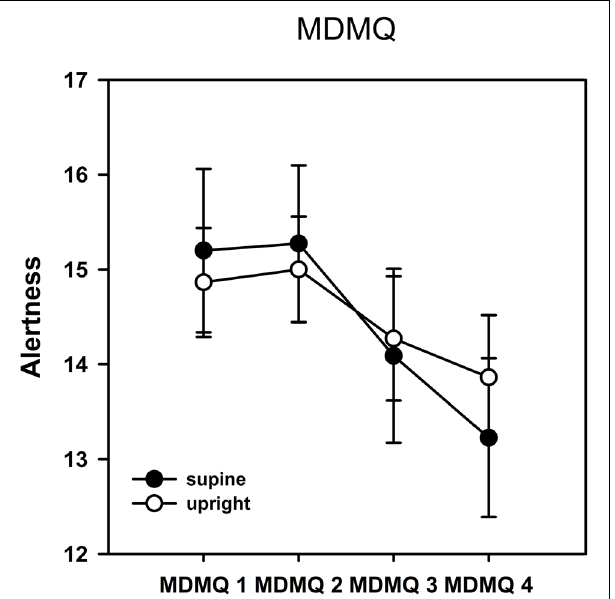
FIGURE 2 | Results from the Multidimensional Mood Questionnaire (MDMQ)–alertness scale. Error bars indicate SEM. Alertness decreased significantly over time but there was no significant difference between postures. No significant time or posture effects were observed on the calmness or valence